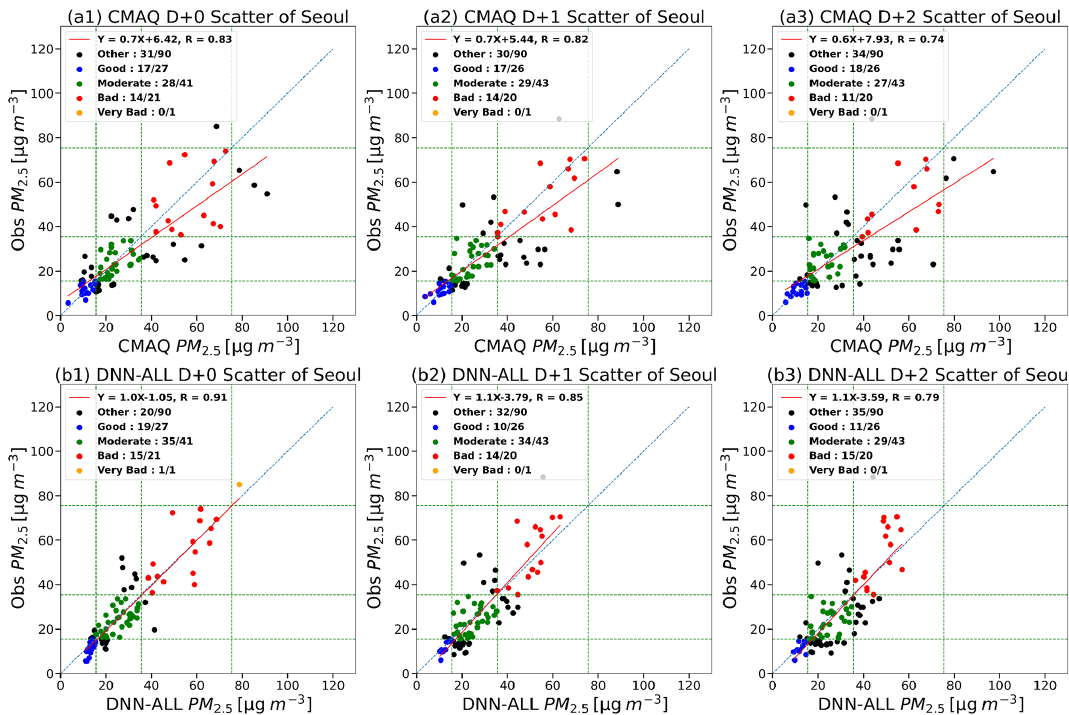
Figure 8. Observations from D + 0 to D + 2 and corresponding scatter plots of the DNN-ALL and CMAQ models. Panels (a1) – (a3) show the scatter plot of the CMAQ model and observation. Panels (b1) – (b3) show the scatter plot of the DNN-ALL model and observation. The blue dots indicate the observation and prediction values in the AQI category “good”; the green dots, “moderate”; the red dots, “bad”; and the orange dots, “very